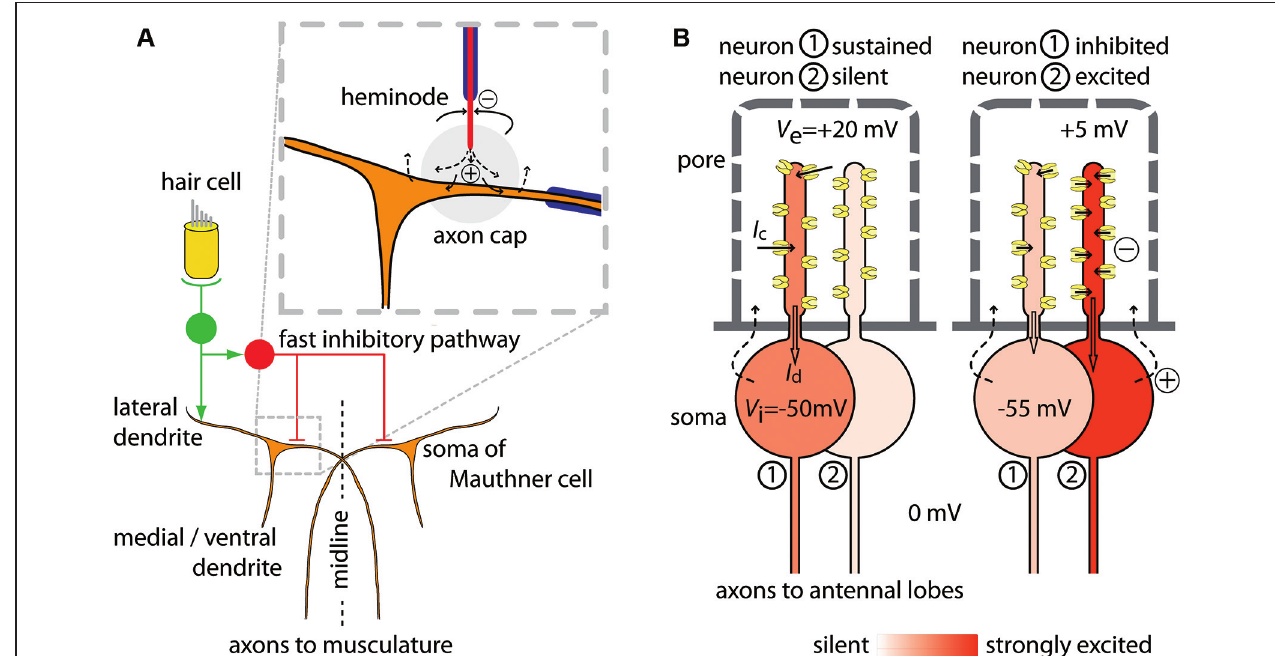
through which odor molecules enter. The hair lumen forms a compartment holding the dendrites of the two neurons. At left, neuron 1 shows a sustained response to odor and neuron 2 is silent. An odorant causes channels to open in neuron 1 and each open channel carries a current I c , which sum to the dendritic current I d (block arrow) that depolarizes the soma region. At right, neuron 1 is inhibited by the transient excitation of neuron 2. Opening of many channels in neuron 2 draws current from the extracellular dendritic space, which reduces V e also for neuron 1. The per-channel current I c decreases, so that I d in neuron 1 also decreases and the soma becomes less depolarized. Illustrative values of potentials are given for V i and V e . The return source current (dashed arrows) follows a complex path, and also involves auxiliary cells (not shown). For both (A) and (B) : currents from sources are shown as dashed arrows; currents to sinks are shown as solid arrows; sources and sinks are defined as in Buzsáki et al.